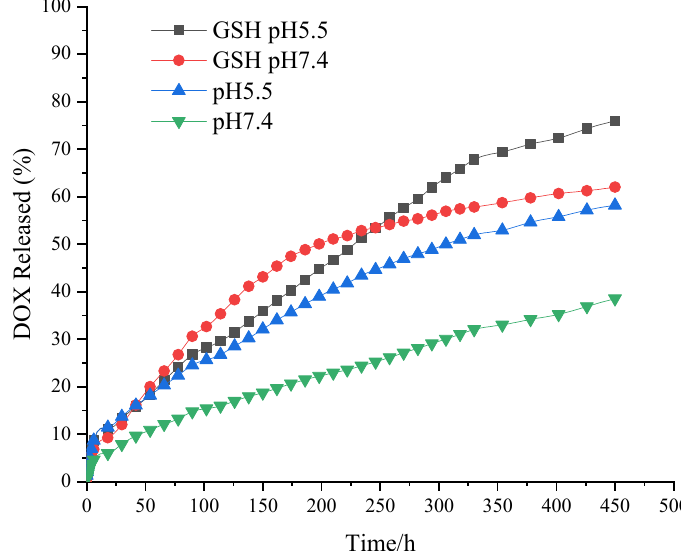
Figure 11. The Dox-loaded hydrogel was investigated for controlled release in PBS solutions having GSH + pH 5.5, GSH + pH 7.4, pH 5.5 and pH 7.4.